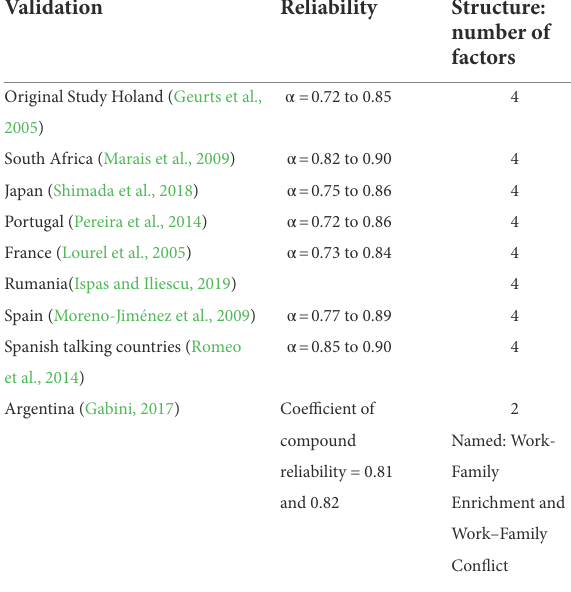
TABLE 1 Psychometric data of the SWING scale and its validations to other